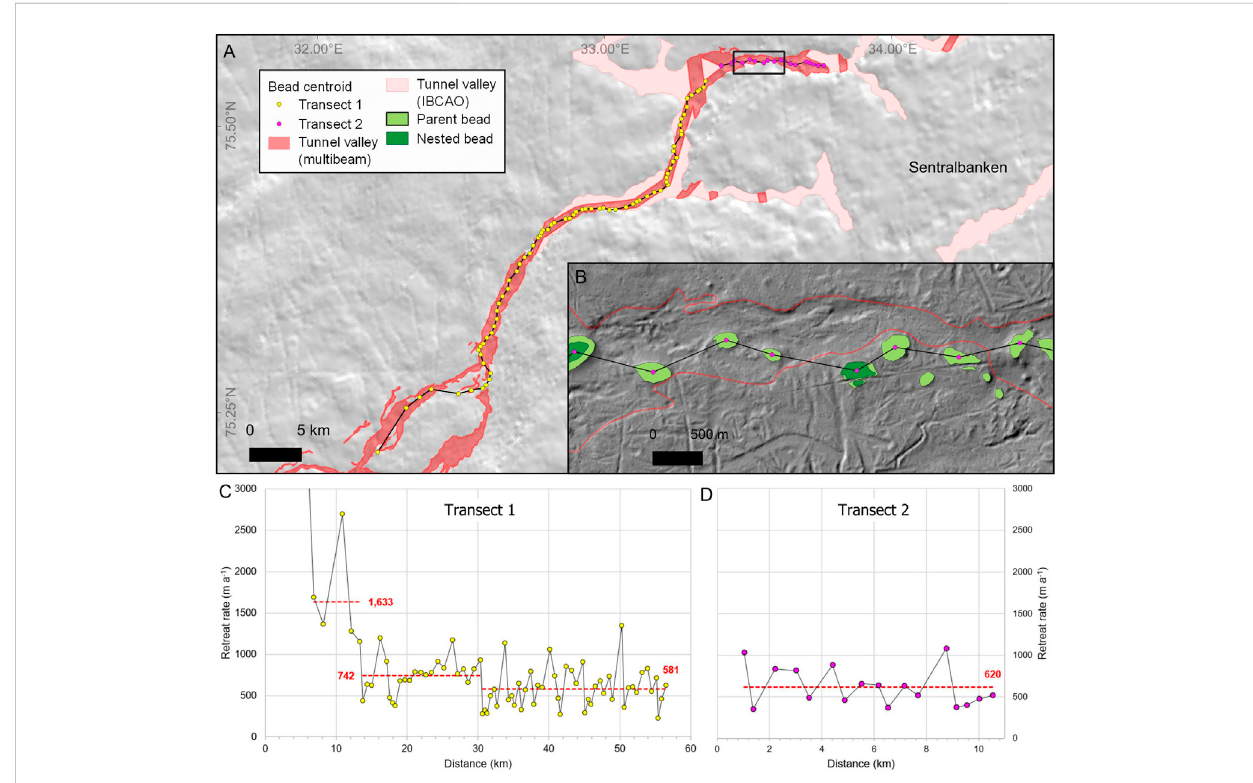
FIGURE 12 (A) Transects along the Hopendjupet beaded-esker system (separated by a gap in multibeam bathymetry data coverage), used to constrain annual retreatratesofthecollapsing BarentsSeaicesheet(SupplementaryMaterialS1). (B) CloserviewofeskerbeadsinTransect2,highlightingtheirplacement within and adjacent to the tunnel valley. (C) Ice-retreat rates through transect 1, with mean values indicating a general deceleration upstream. (D) Ice- retreat rates through transect 2, highlighting continued